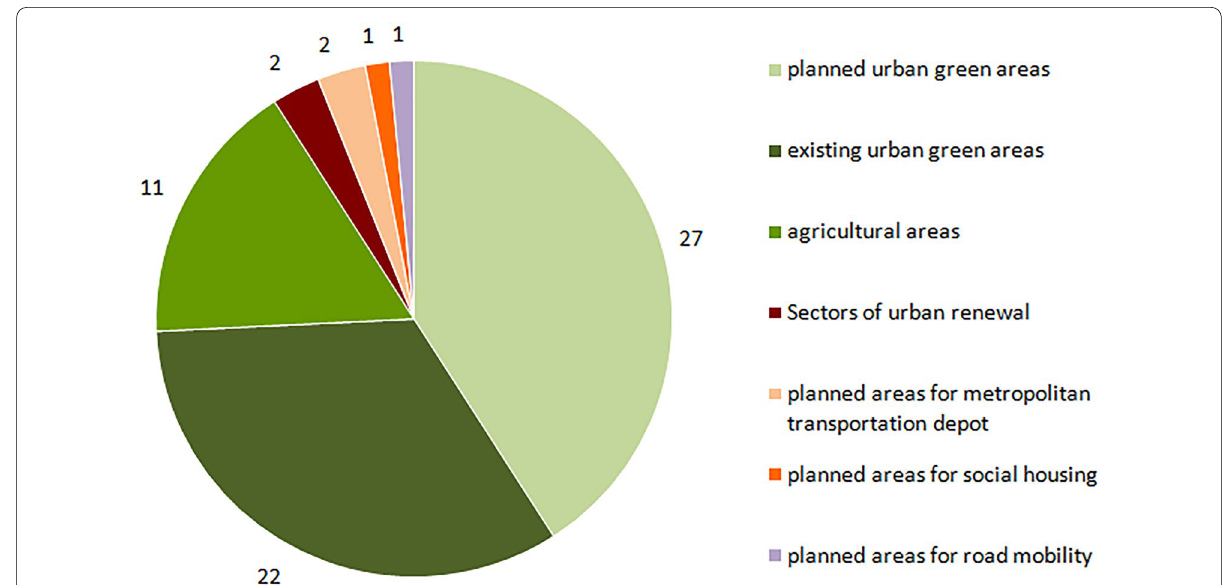
Fig. 12 Milan city plan 2019_ Plan of Rules_ Table R.02 urban planning